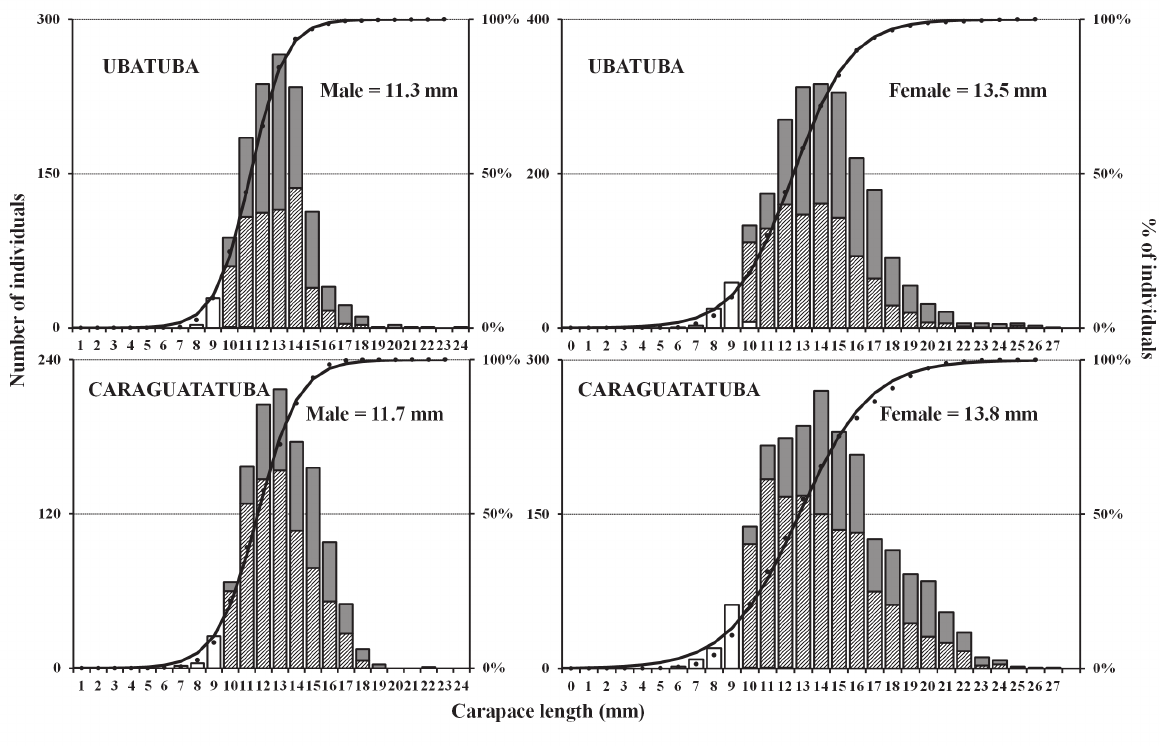
Figure 2 - Size frequency distributions and sexual maturity based on the CL50 (carapace length) of males and females sampled in Ubatuba and Caraguatatuba regions, northern coast of the state of São Paulo (Brazil). Unfilled bars: juvenile males and females; hatched bars: spermatophore-lacking males and spent females; shaded bars: spermatophore-bearing males and reproductive